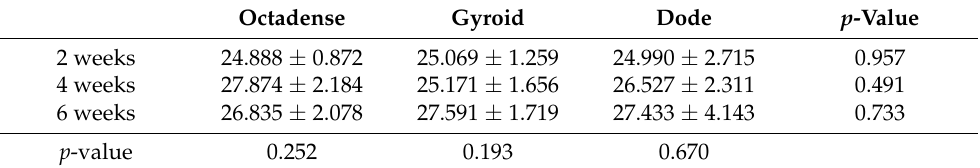
Table 1. New bone volume (%) of 3D-printed porous titanium with variable pore design.